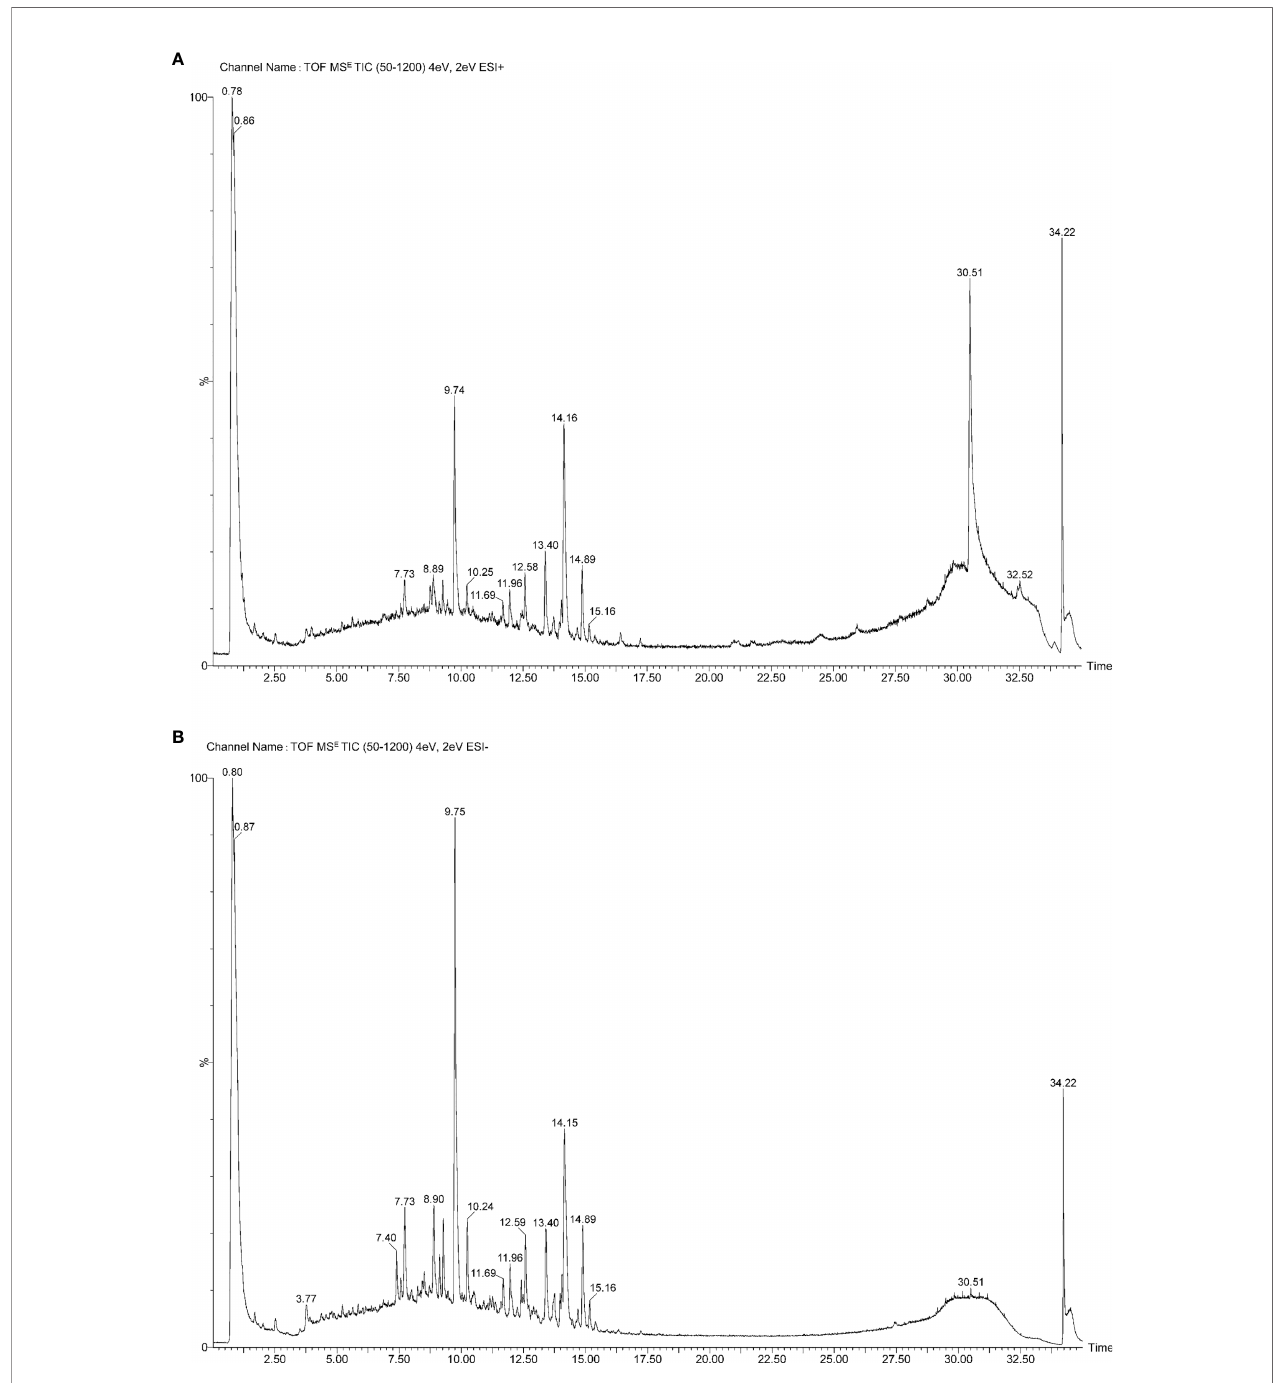
FIGURE 1 | Analysis of chemical constituents in compound prescription by UPLC-Q-TOF-MS. (A) The primary total ion fl ow diagram of SCTWD under positive ion mode. (B) The primary total ion fl ow diagram of SCTWD under negative ion